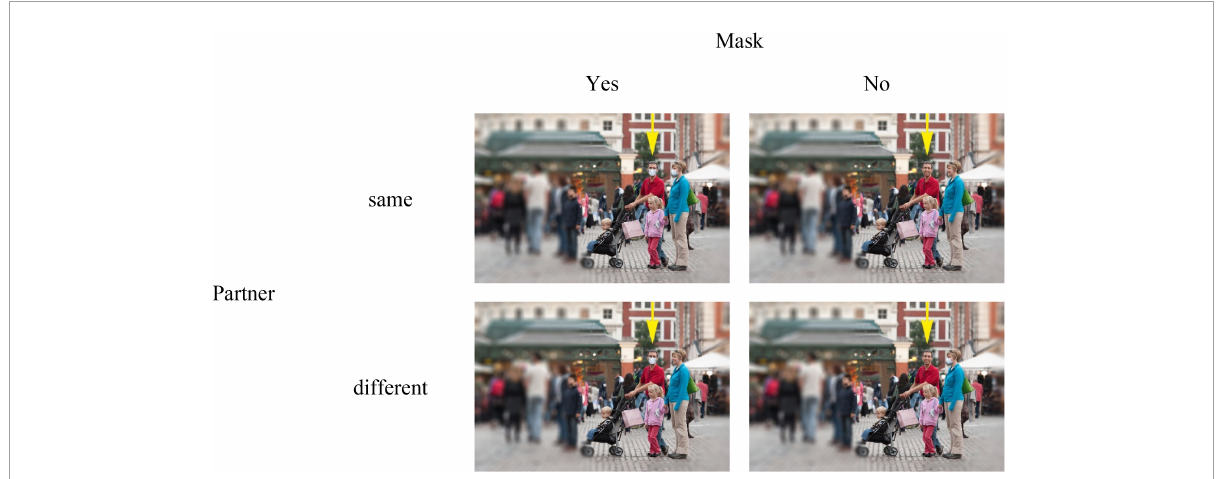
FIGURE2 Stimuli used in experiment 1. The figure shows all variations for the male target person. For the female target person, the arrow was moved above the female, respectively. To ensure the anonymity of the people displayed in the photograph, faces were blurred for the published manuscript. The original photo (without face masks and blurring effects) was kindly made public by Jason Pier through a CC BY-NC 2.0 license.